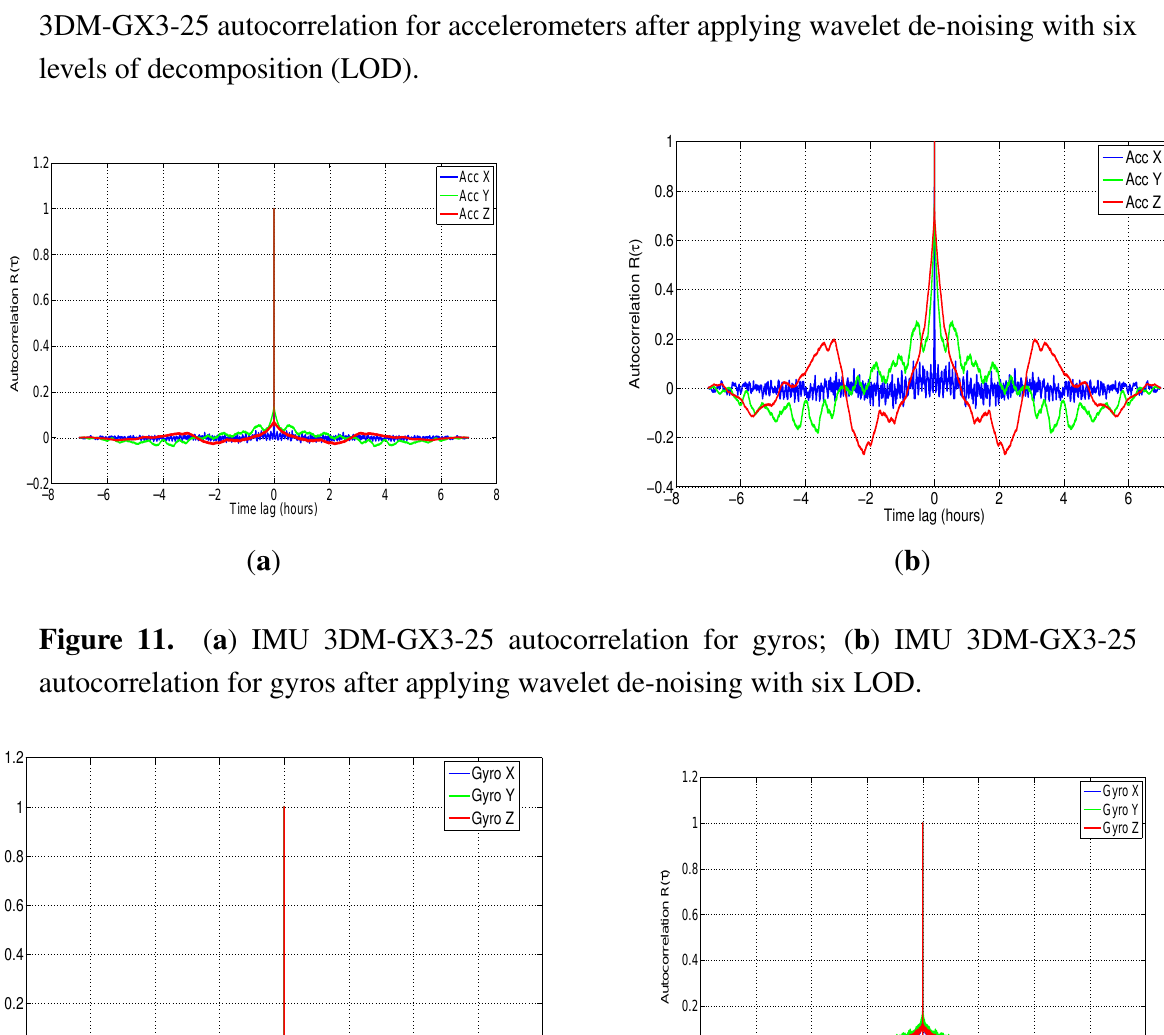
3DM-GX3-25 autocorrelation for accelerometers after applying wavelet de-noising with six